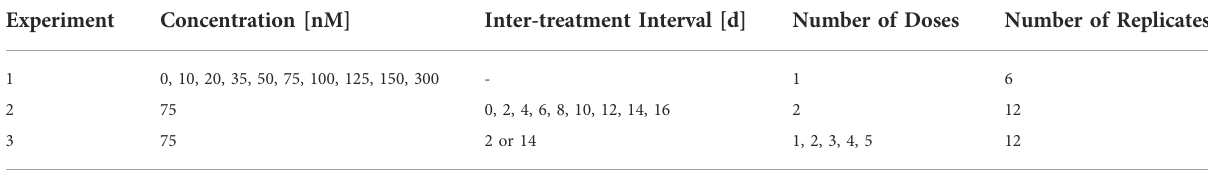
TABLE 1 Experimental conditions. In Experiment 1, one dose of doxorubicin was delivered at concentrations varying from 10 to 300 nM ( n = 6). In Experiment2,twodoses of75 nMdoxorubicinwere deliveredat inter-treatmentintervals varyingfrom0to16days( n =12). InExperiment3,one to fi ve doses of 75 nM doxorubicin were delivered at either 2-day or 2-week inter-treatment intervals ( n =